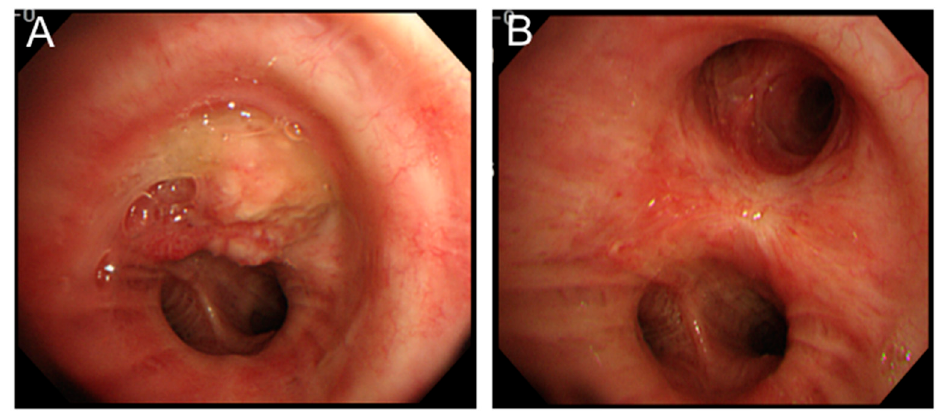
Figure 2. PDT for central type lung cancer. ( A ) Endobronchial tumour (squamous cell carcinoma) completely obstructing the left upper lobe bronchus and extending into the left main stem bronchus; ( B ) complete response to PDT with only scarring on follow up bronchoscopy one year post PDT.